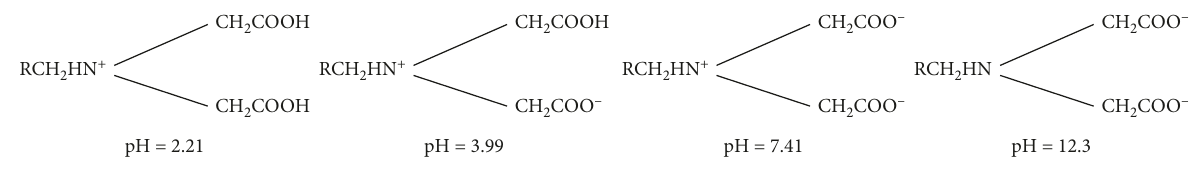
Figure 3: Effect of pH in the iminodiacetate functional group [40].